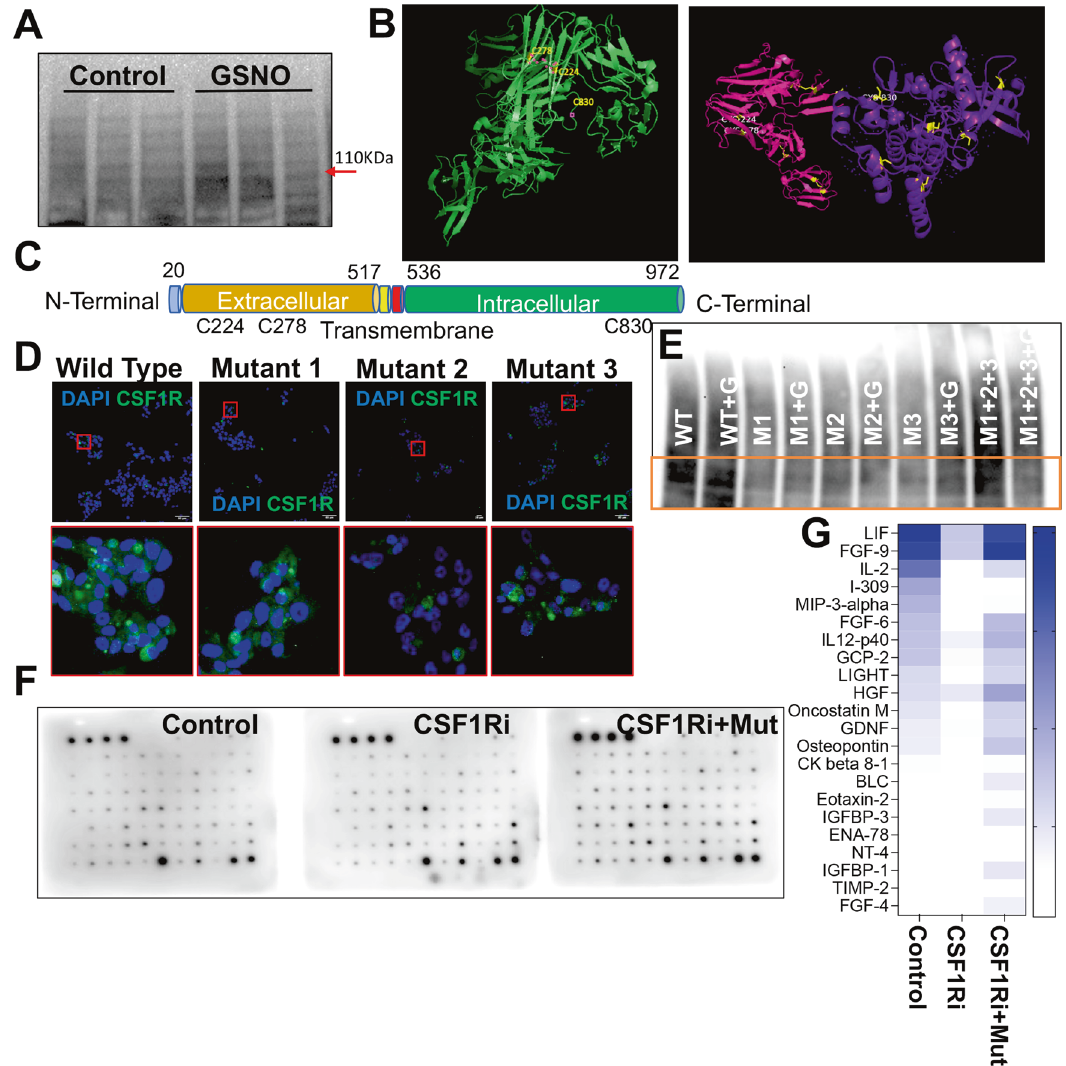
structure of CSF1R showing 3 cysteine sites highlighted in yellow with the highest threshold for nitrosylation. C A topology map of CSF1R showing intracellular and extracellular domains and the location of cysteine sites. D Representative images show sub-cellular localization of wild-type and three CSF1R mutants (M1, M2, and M3) with deletions at C224, C278, and C830 cysteine residues in 22Rv1 cells. E S-nitrosylation in cell lysates in 22Rv1 cell transfected with wild-type mutants with deletion at sites C224, C278, and C830 in the presence/absence of 50 μ m S-nitrosoglutathione (GSNO). F Cytokine array image of the 22Rv1 cell lysates under different experimental conditions-untreated control, cells treated with CSF1R inhibitor at 0.5 μ m dose, and cells transfected with all 3 mutants along with the CSF1Ri. G Heat map showing different cytokines differentially expressed in cell lysates treated with CSF1Ri and CSF1R mutants with CSF1Ri. Data are presented as mean ± SEM. *** P < 0.001; ** P <